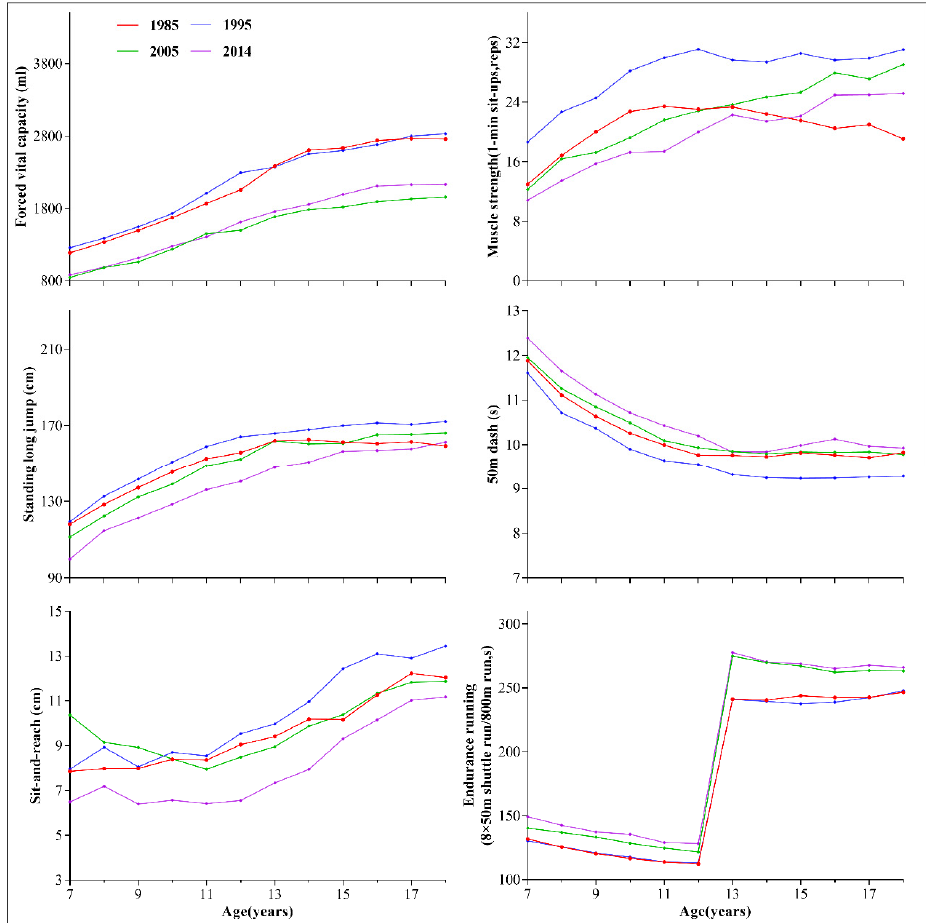
Figure 2. Trends in the six core items of physical fitness among girls aged 7–18 in Xinjiang, from 1985 to 2014.